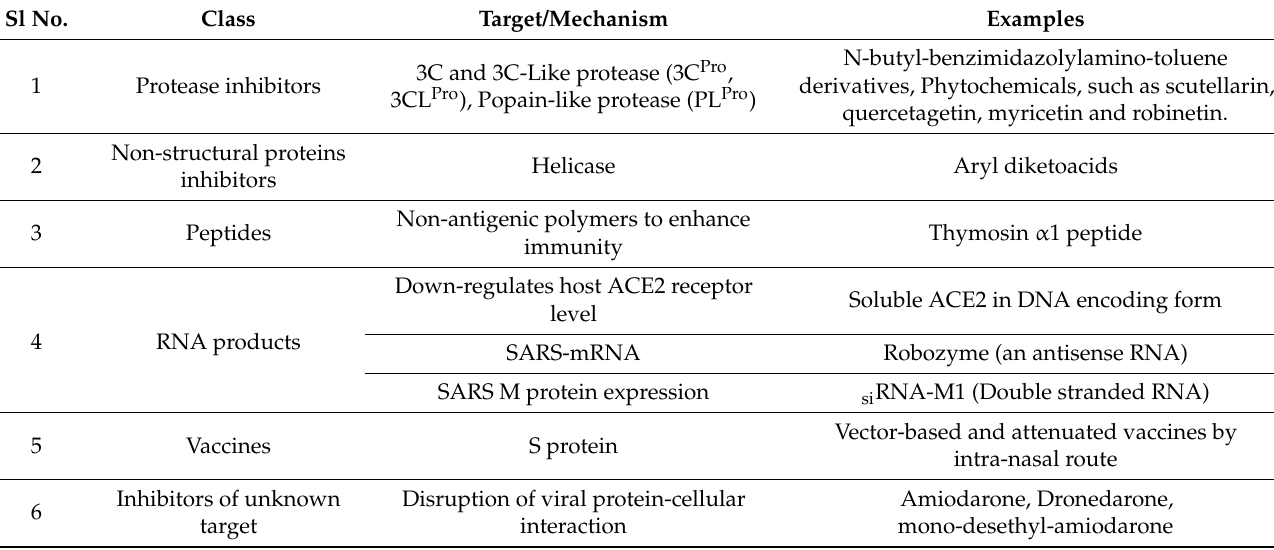
Table 1. List of important drugs in the pipeline against COVID-19